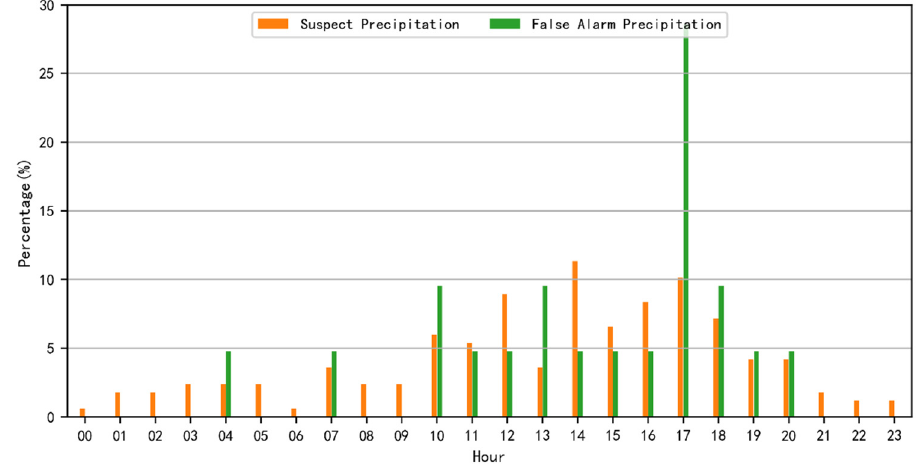
Figure 12. Temporal distribution of suspicious and false alarm precipitation.